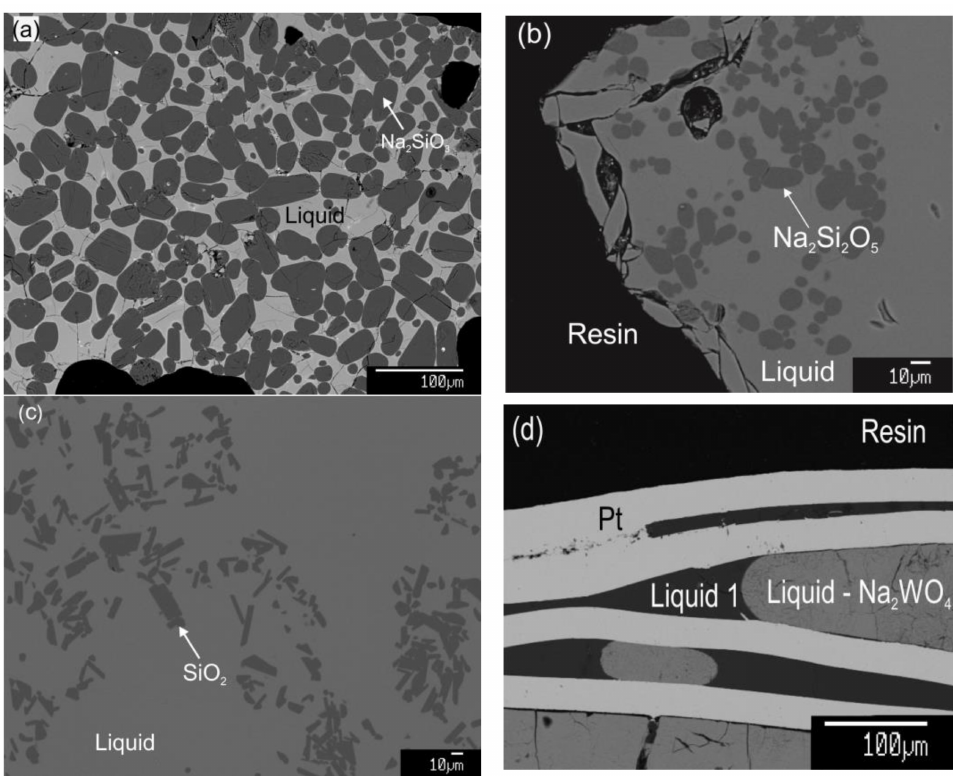
Figure 2. Typical backscattered scanning electron micrographs of quenched samples in the Na 2 O-SiO 2 -WO 3 system, ( a ) WE5—sodium metasilicate with liquid phase; ( b ) WE6—sodium disil- icate with liquid phase; ( c ) WE9—tridymite with liquid phase; ( d ) WE10—sodium tungstate with liquid phase.